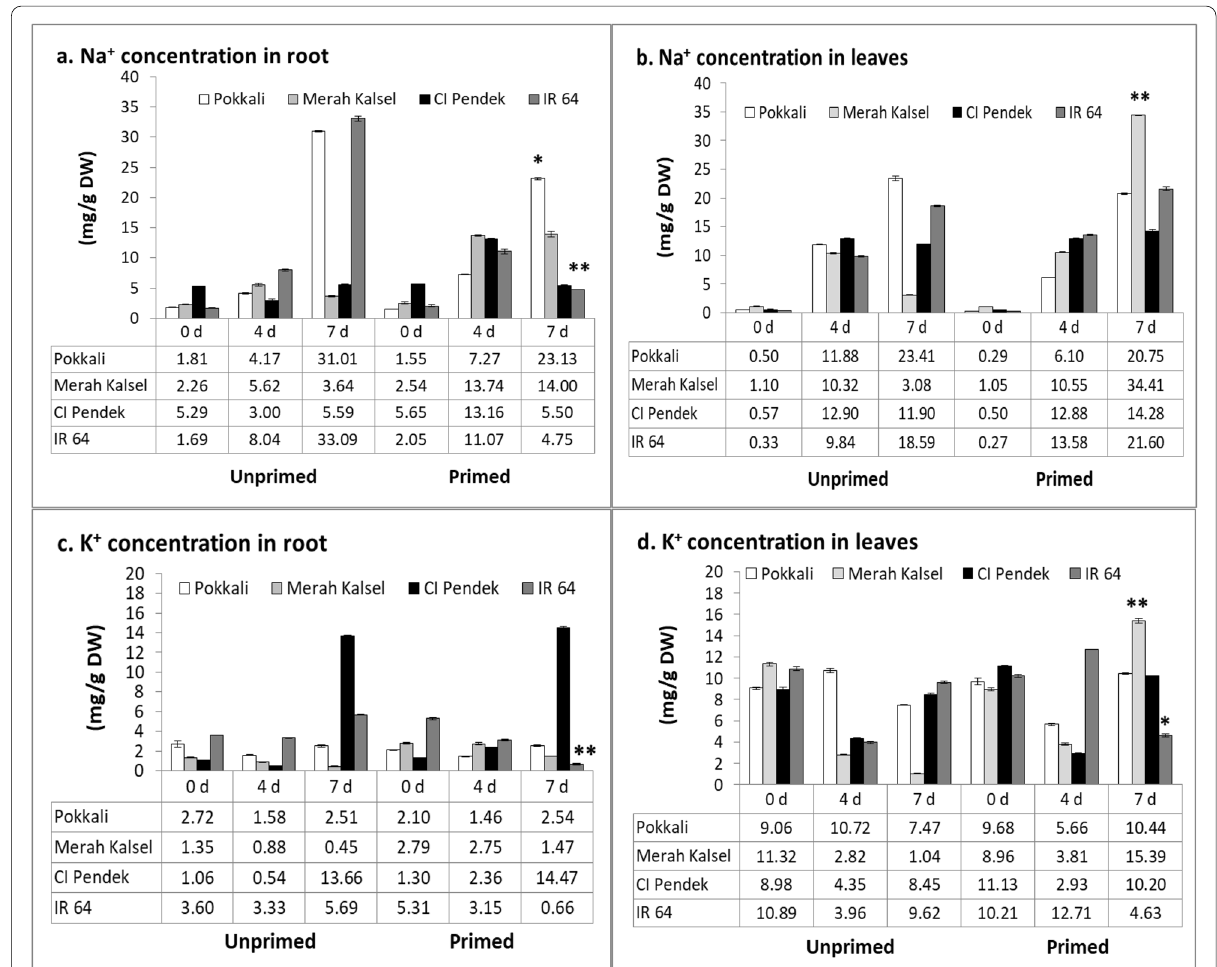
Fig. 4 Concentration of Na + and K + ions of rice plants after 7 days exposed to salinity stress. a , c Na + and K + ion concentration in roots. b , d Na + and K + ion concentration in leaves were measured at 0, 4, and 7 days of salinity treatment (200 mM NaCl). Values are means of three replicates * p < 0.05, ** p < 0.01, LSD test. DW: dry